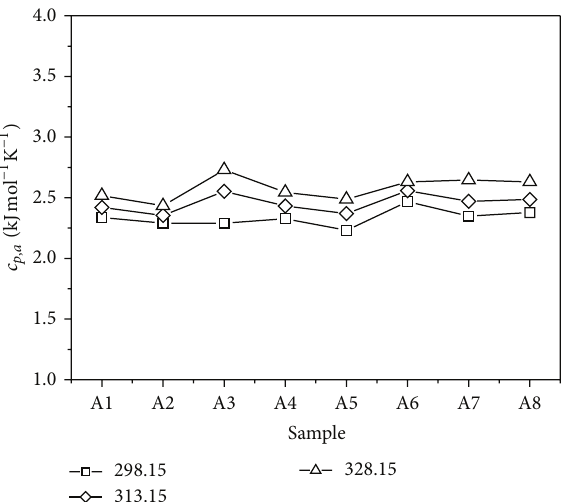
Figure 9: Comparison of 𝑐 𝑝,𝑎 values evaluated for methane adsorp- tion onto the coals at 𝑃 = 0.1